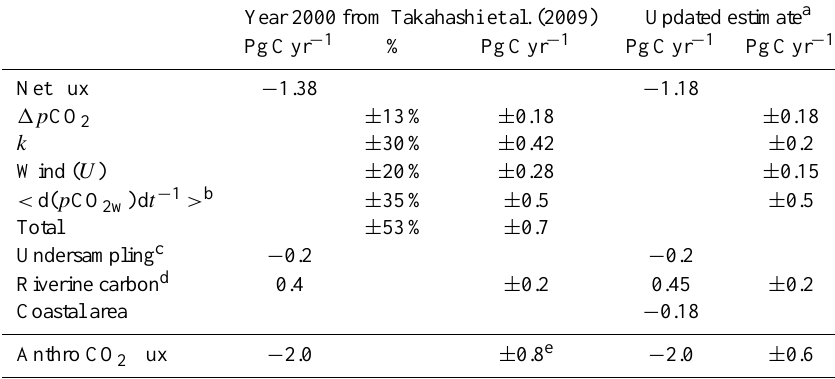
Table 1. Summary of different components of the globally integrated sea–air CO 2 flux estimate including the sources and magnitude of the